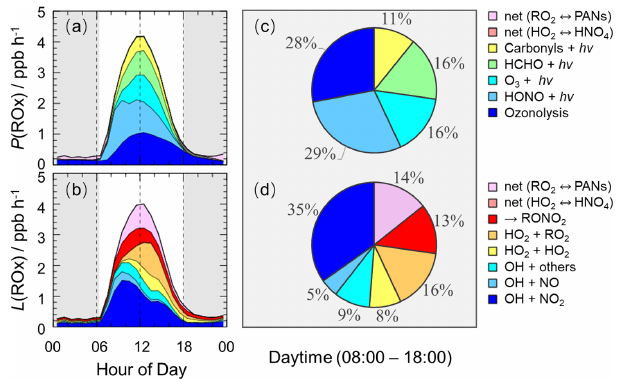
Figure 7. The diurnal profiles of the RO x primary production rate (a) and termination rate (b) simulated by the base model, and the contributions of different channels to the RO x primary produc- tion rate (c) and termination rate (d) during the daytime (08:00– 18:00CST). The grey areas denote